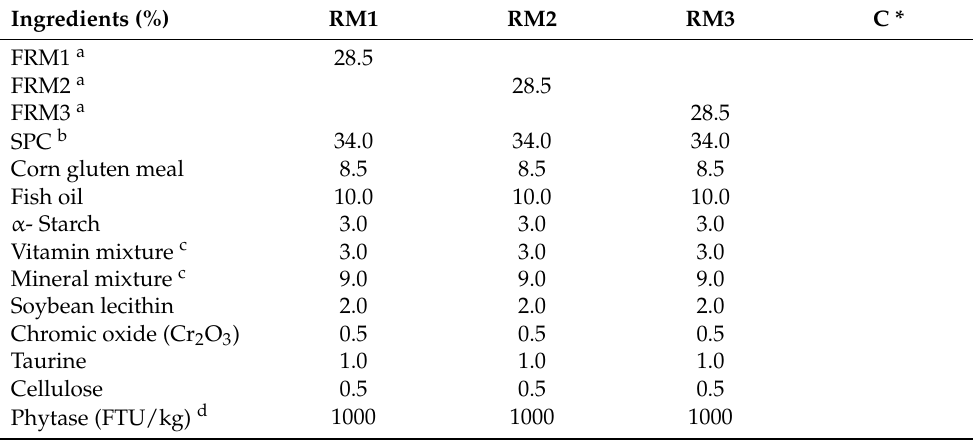
Table 4. Formula and proximate composition of experimental diets used in Trials 2 and